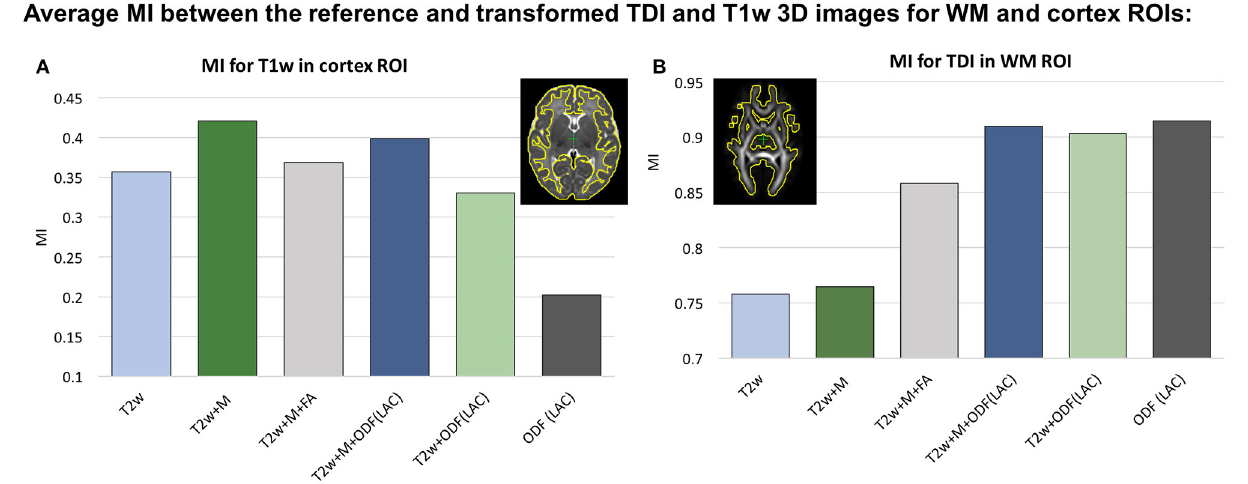
FIGURE 4 | Comparison of MC registration results for different combinations of channels. The performance was measured by mutual information (MI) between aligned images and the age- and contrast-mached templates for (A) the T1w images in the cortical region and (B) TDI maps in the WM region. The regions are highlighted in yellow contours. The results are statistically significant with p < 0.001 for all cases apart from: all ODF -guided scenarios for the WM ROI, T 2 w vs. T 2 w + M cortex for WM ROI and T 2 w vs. T 2 w + M cortex + FA for the cortex ROI.